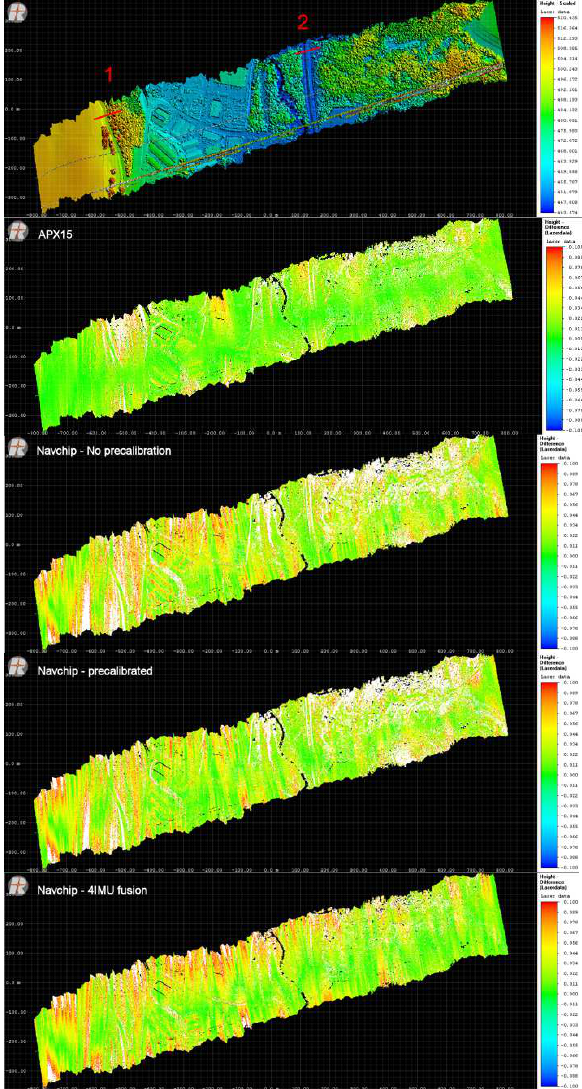
Figure 7: Reference hillshade (top plot) generated with AIRINS and the differences in elevation for point-clouds based on (1) APX15, (2) 1Navchip w.o. precalib., (3) 1Navchip w. precalib., (4) Navchip-SIMU. The scale goes from 0 (green) to +/-10 cm (red/blue). White areas are greater than +/- 10